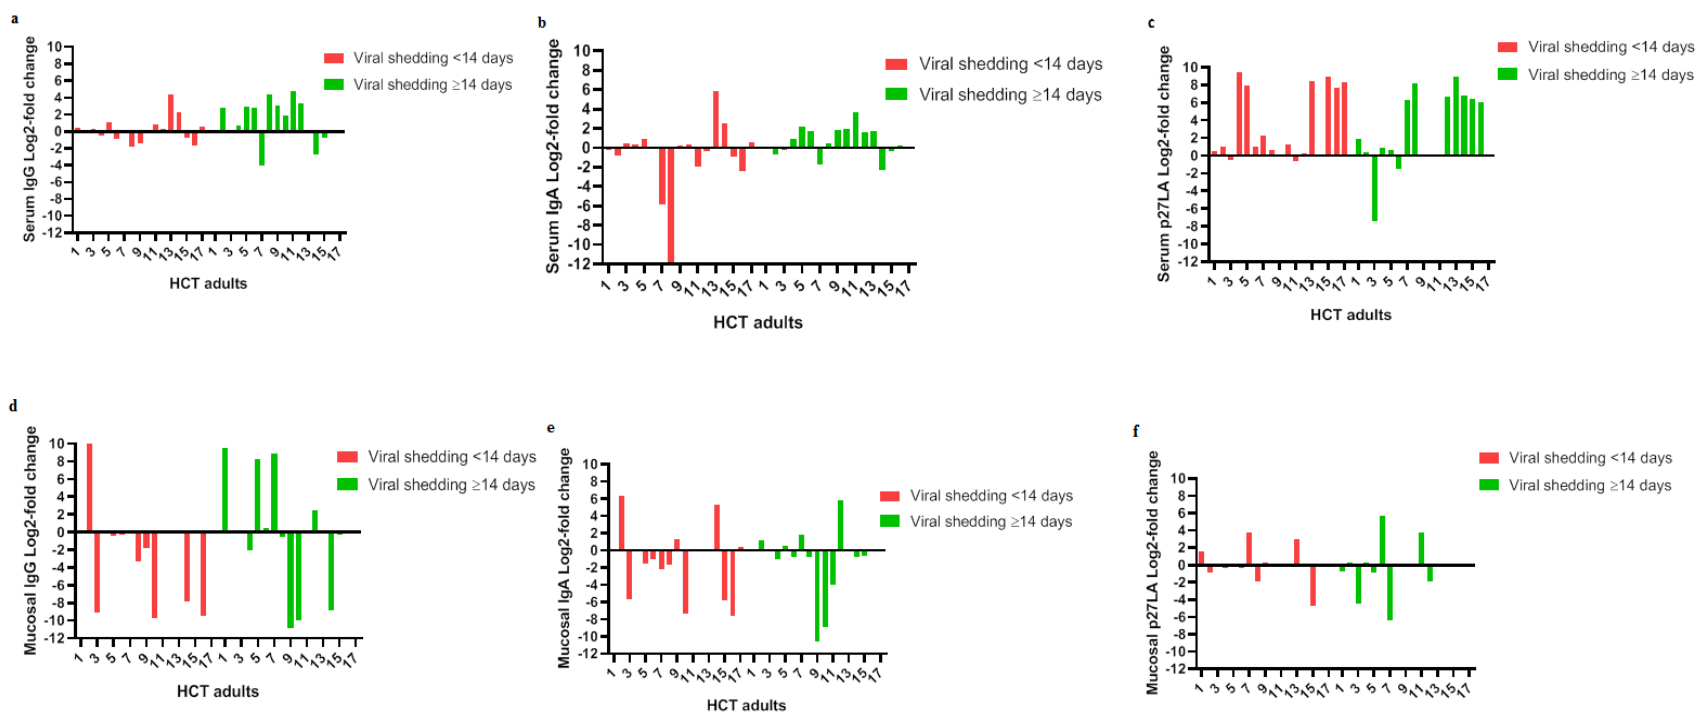
Figure 3. Log2-fold change in p27 antibody concentration between the convalescent to acute samples by RSV infected HCT recipients who shed RSV < 14 days ( n = 17) and > 14 days ( n = 16). For the serum samples, 9 (27.2%), 4 (12.0%) and 14 (42.4 %) HCT recipients ( n = 33) had a 4-fold rise in the serum IgG, IgA and P 27 LA, respectively ( a – c ). For nasal washes, 5 (15.0%), 3 (9.0%) and 4 (12.0%) HCT recipients ( n = 33) had a > 4-fold rise in mucosal IgG, IgA and P 27 LA, respectively ( d – f ). In contrast, 9 (27.2%), 8 (24.2 %) and 3 (9.0%) HCT recipients ( n = 33) had a > 4-fold decrease in mucosal IgG, IgA and P 27 LA, respectively ( d – f ). In addition, 5 (~30%) HCT recipients who cleared the virus in < 14 days ( n = 17) had a > 4-fold decrease in mucosal IgG and IgA anti-p27 antibody concentration, respectively ( d , e ). The figure was made by GraphPad Prism version 8.3.0 for Windows, GraphPad Software, La Jolla California USA.